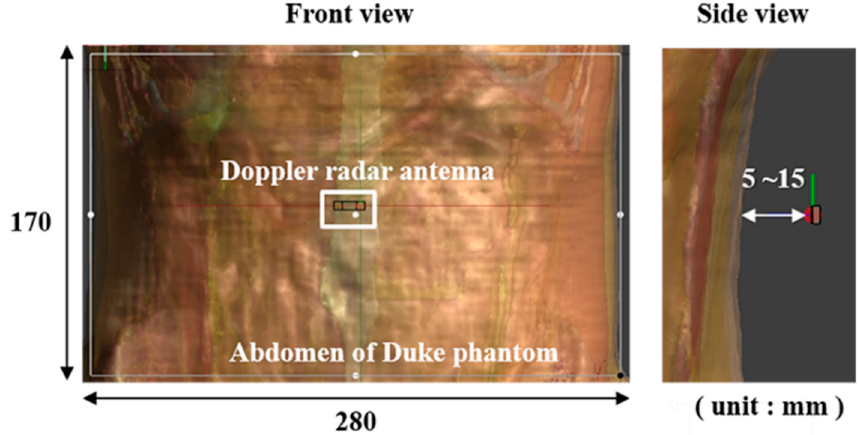
Figure 7. Simulation setup of the designed Doppler radar antenna with Duke phantom in Sim4life.